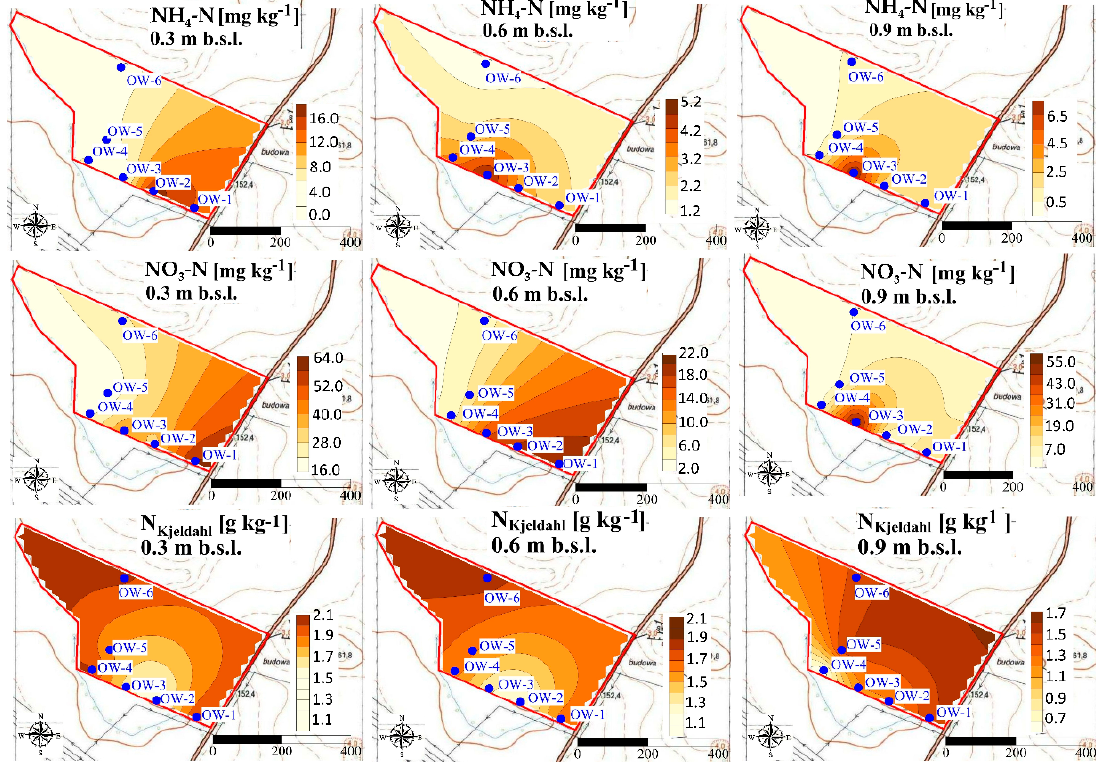
Figure 9. Spatial distribution of ammonium, nitrate, and N Kjeldahl in soil at the A experimental site after VRA fertilization.